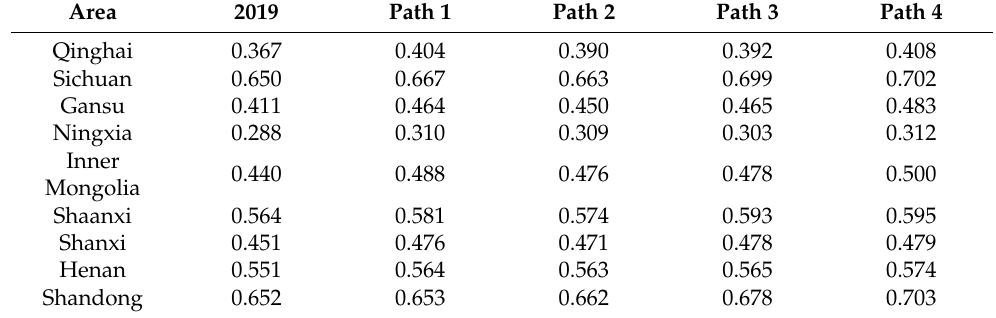
Table 10. The development index of each province in the set of regulatory behaviors.